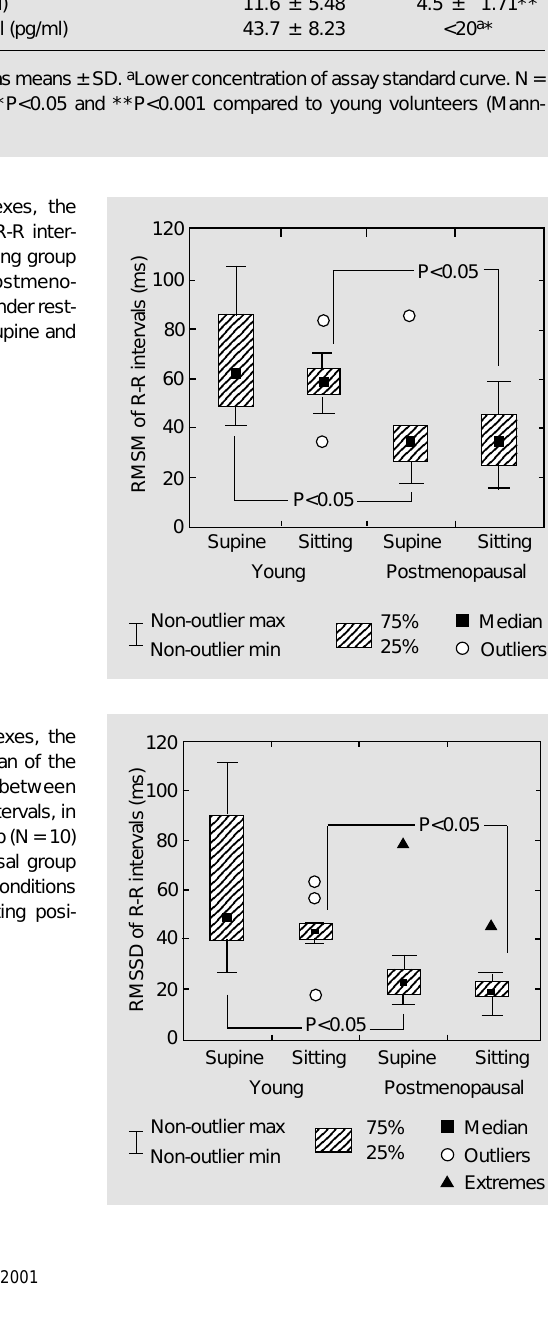
Values are reported as means ± SD. a Lower concentration of assay standard curve. N = 10 for each group. *P<0.05 and **P<0.001 compared to young volunteers (Mann- Whitney test).